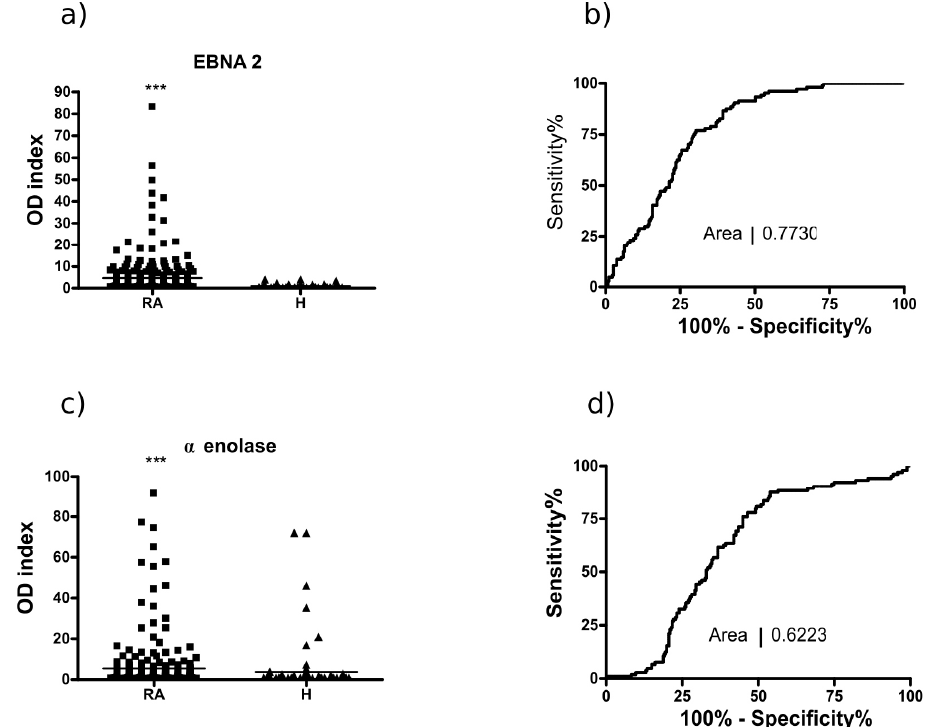
Figure 1. Recognition of citrulline-containing EBNA-2 and α -enolase peptide epitopes by sera of patients (RA, n = 177) and healthy volunteers (H, n = 104): ( a , c ) OD index: OD with Cit-peptide/OD with Arg peptide; and ( b , d ) receiver operating (ROC) curves. *** p ≤ 0.001. RA: rheumatoid arthritis.